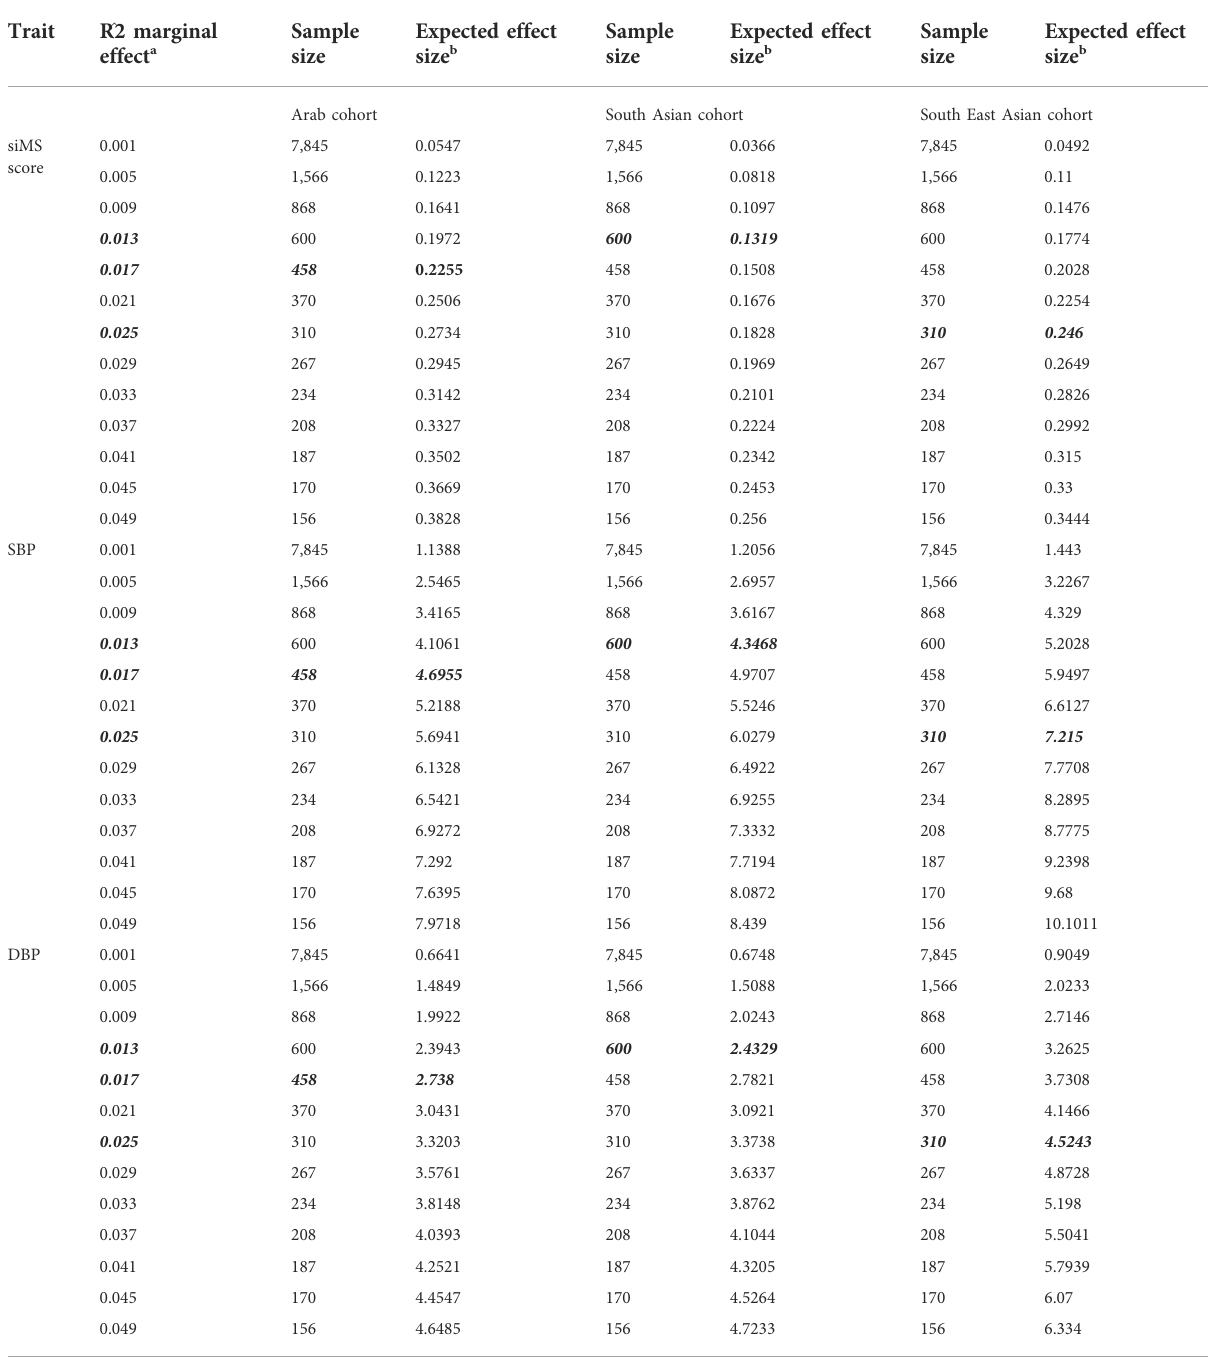
TABLE 5 Power Calculation for the Arab, South Asian and South East Asian cohorts for the traits of siMS score, SBP and DBP found associated in the Arab